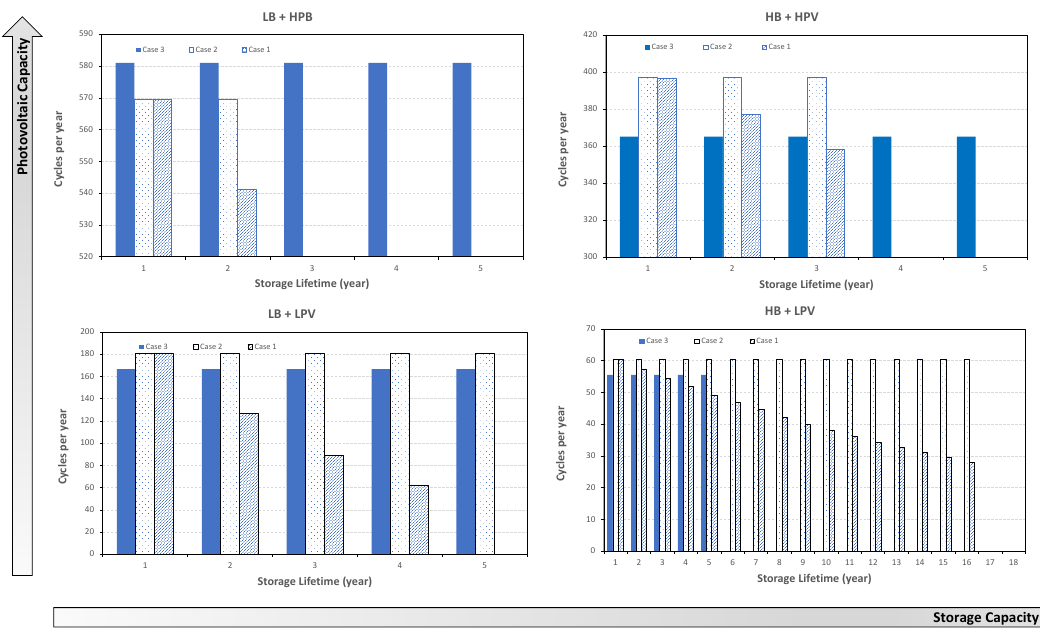
Figure 10. Evolution of the battery cycles over the battery lifetime for all scenarios.